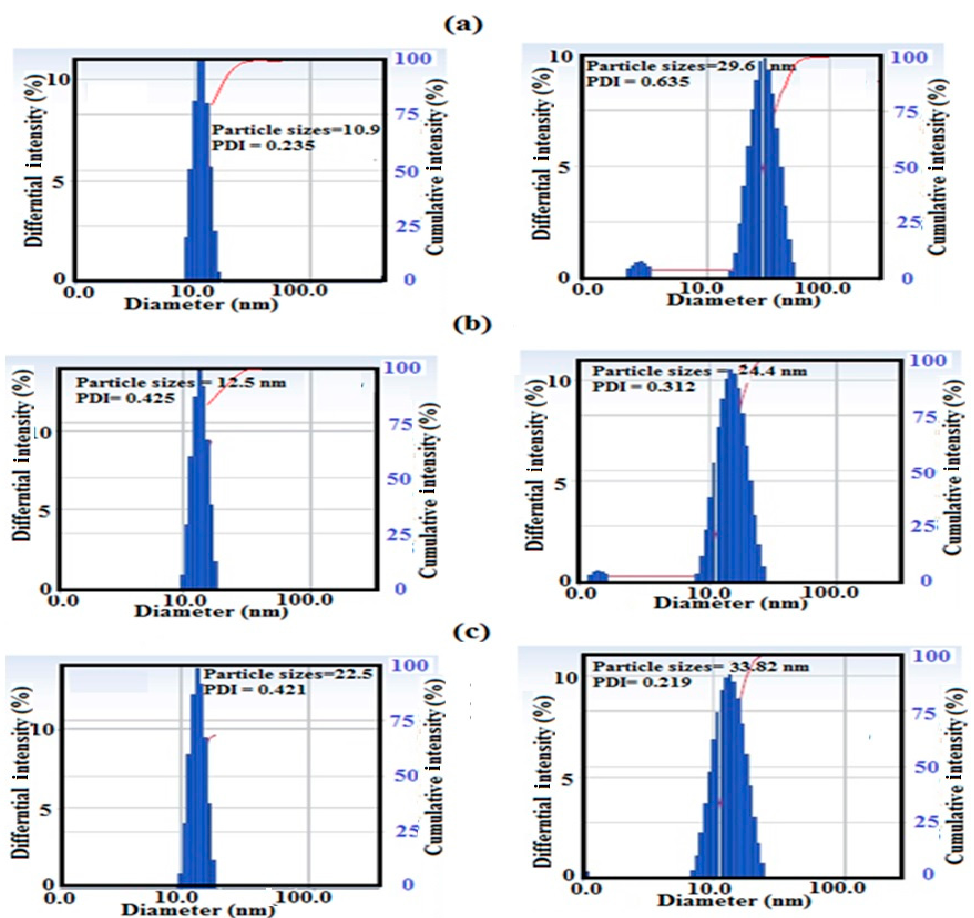
Figure 4. Dynamic light scattering (DLS) data of Si-IL (left) and Fe 3 O 4 -Si-IL (right) at different pHs, namely, ( a ) 4, ( b ) 7, and ( c ) 9 in aqueous solution in the presence of 0.001 M KCl.